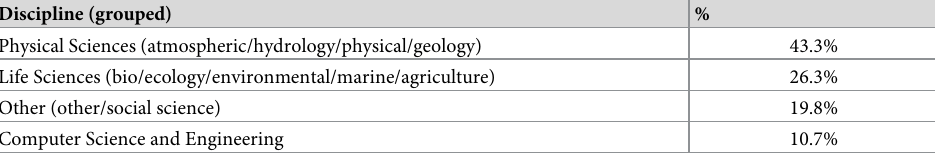
Table 1. “Which one of the following best describes your primary subject discipline?” (grouped) (n = 2098). Discipline (grouped)